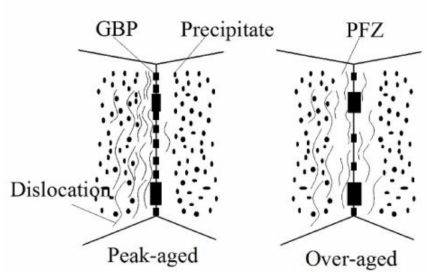
Figure 13. Schematic representation of dislocation motion process during fatigue crack